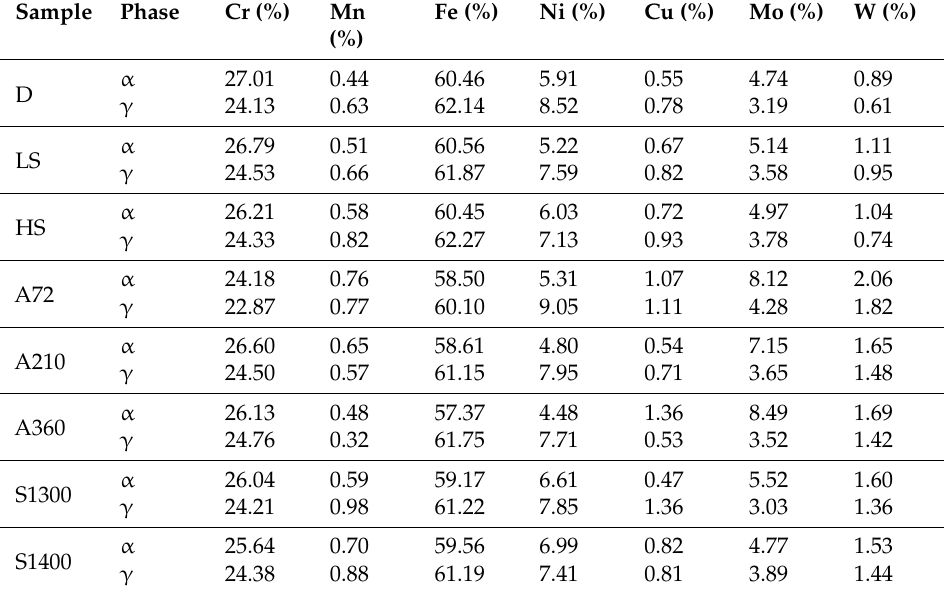
Table 2. Local chemical composition (wt. %) measured within austenitic and ferritic phases.